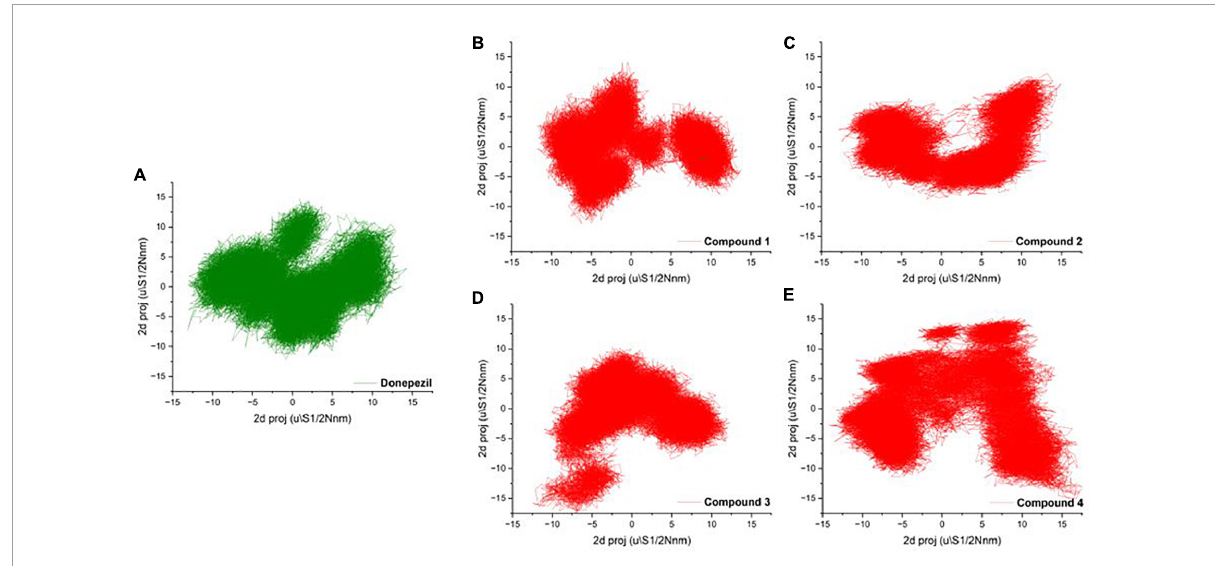
FIGURE4 (A–D) 2D projection of the trajectory allocation for the motion of the proteins in complex with (A) Donepezil, (B) Compound 1, (C) Compound 1, (D) Compound 3, and (E) Compound 4 in the essential